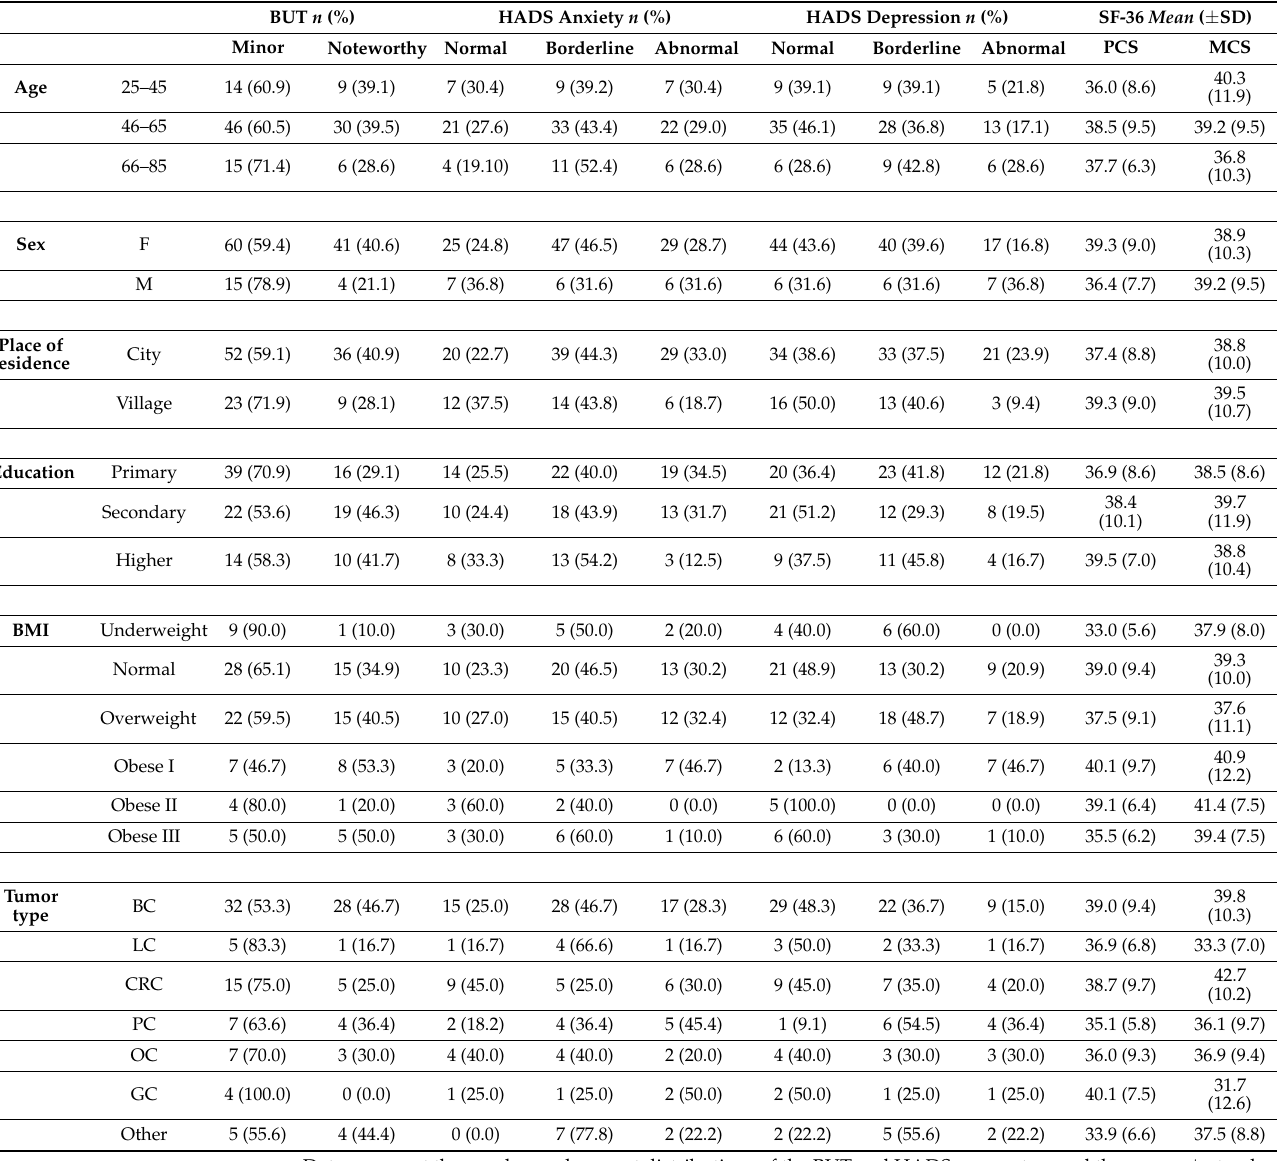
Table 3. Distribution and associations of the BUT, HADS and SF-36 components with patient